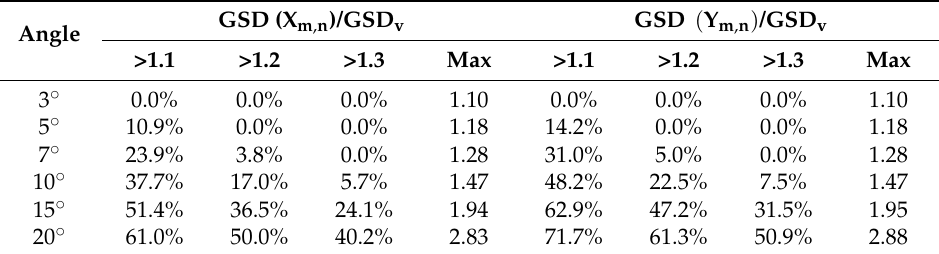
Table 2. Statistical information of the GSD distribution with the changing angle.